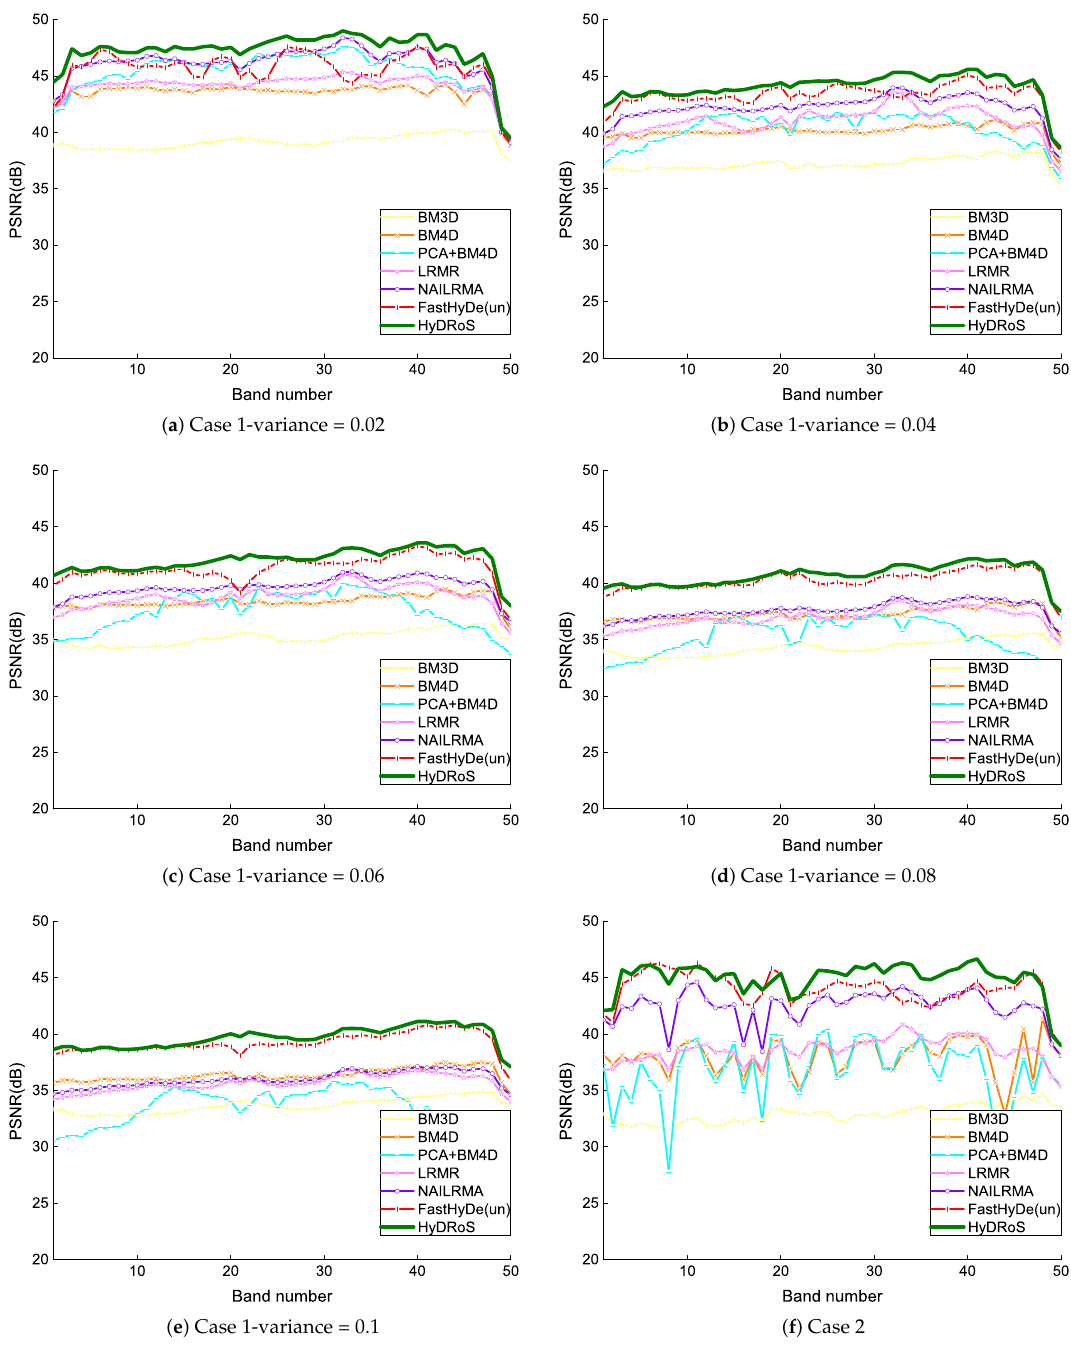
( e ) Case 1-variance = 0.1 Figure 5. PSNR of each band after denoising for different noise variances: ( a ) σ =0.02; ( b ) σ = 0.04; ( c ) σ = 0.06; ( d ) σ = 0.08; ( e ) σ = 0.1; ( f ) mean( σ ) =